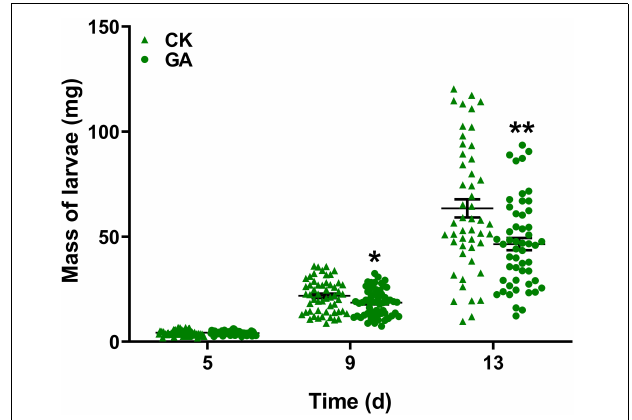
FIGURE 1 | Effect of gallic acid (GA)-treated tea plants on Ectropis obliqua larval weight gain. Data are presented as means ± SE ( n = 50), and asterisk indicates significant differences between GA treatment and control (* P < 0.05, ** P < 0.01, Student’s t -test).